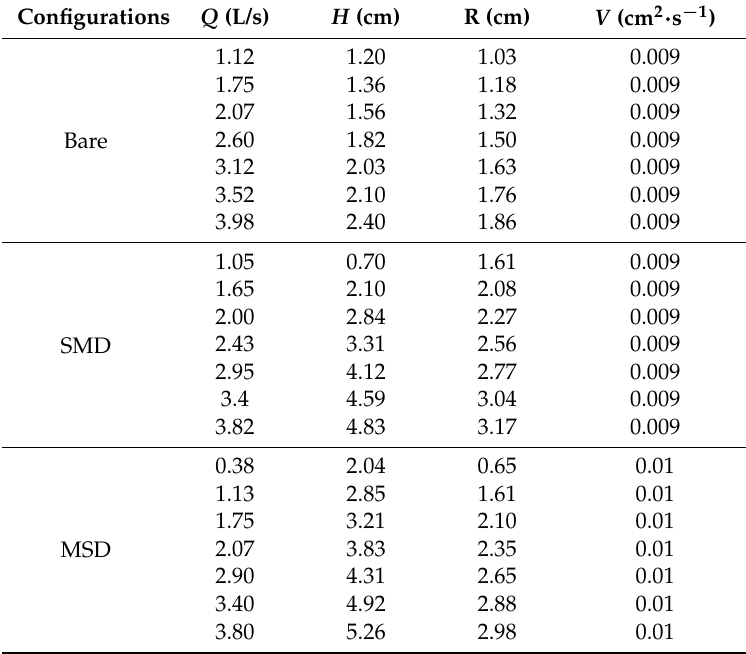
Table 1. Main data of the